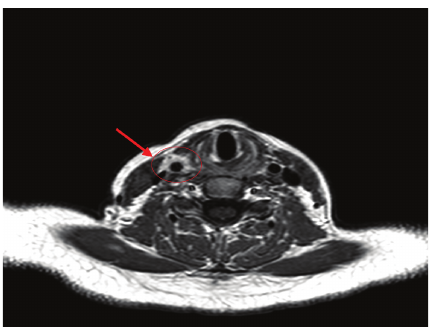
Figure 1: Magnetic resonance (MR) imaging of the neck. MR shows localized enhancement in T1-weighted images involving right medial-distal common carotid artery (arrow); the thickening of perivascular soft tissue might be the result of localized vascular